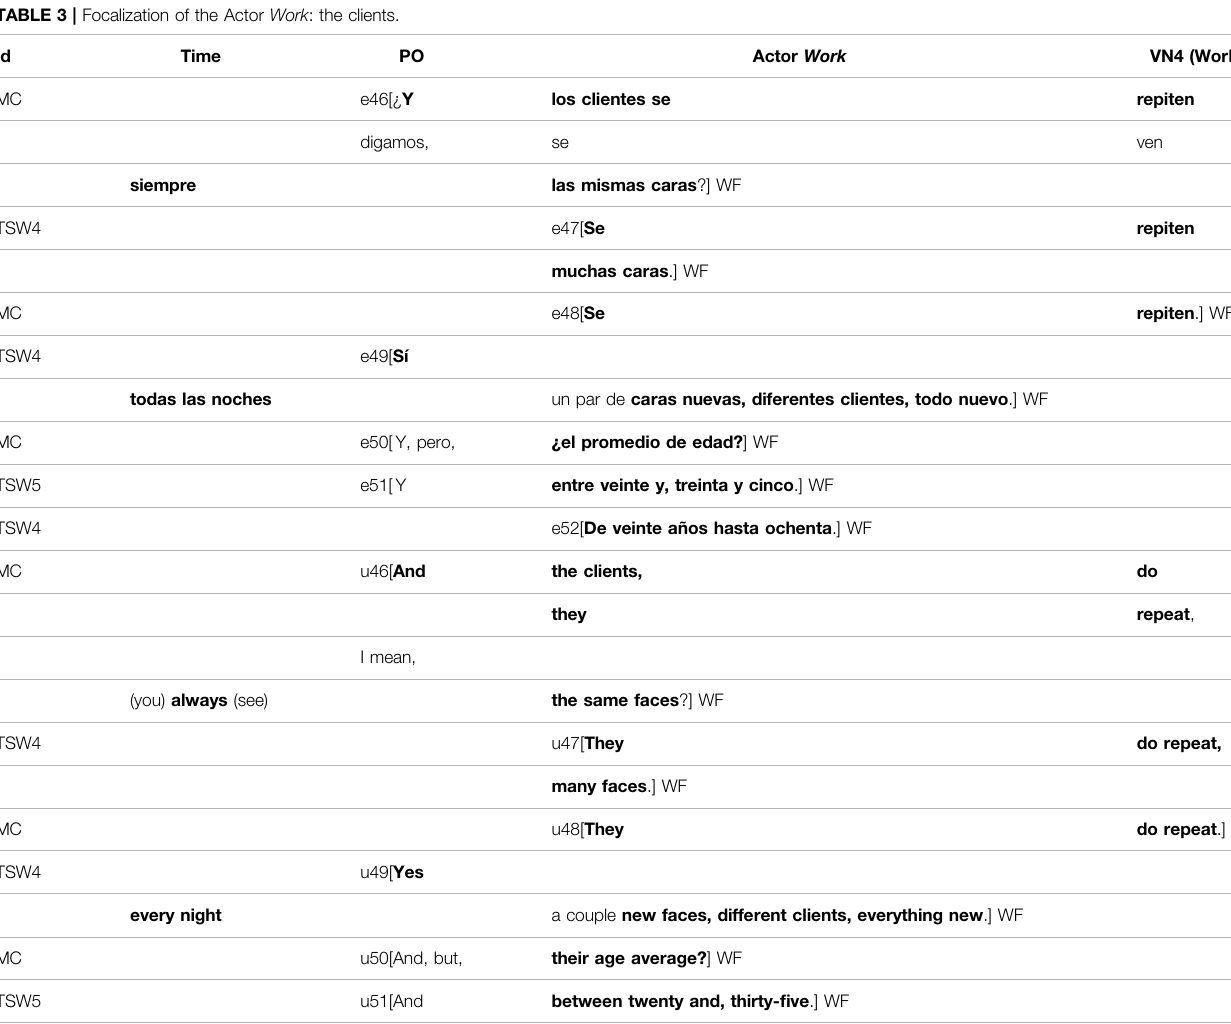
TABLE 3 | Focalization of the Actor Work : the